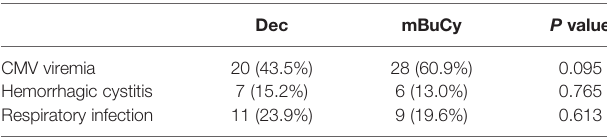
TABLE 1 | Characteristics of matched patients ’ cohort. TABLE 2 | Incidence of transplantation-related infectious